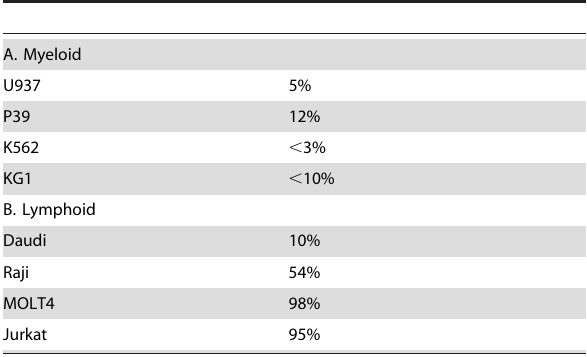
Table 2. Flow cytometry analysis of CXCR7 expression in acute leukemia cell